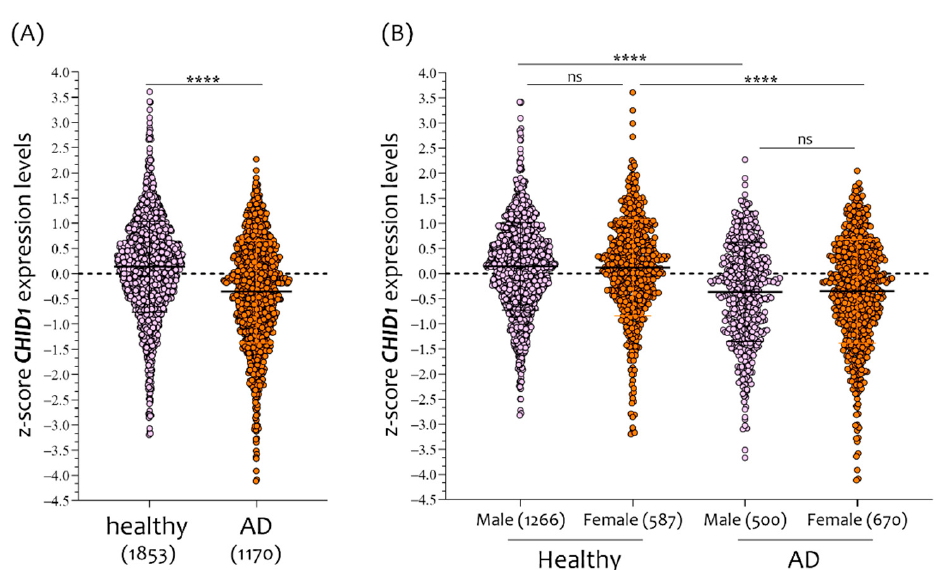
Figure 1. Sex-dependent difference in CHID1 brain expression of NDHC subjects. Analysis of CHID1 expression levels in 1853 NDHC brains subjects and 1170 AD brains patients ( A ), placed in order according to the sex ( B ). Data in the figure are indicated as z-score intensity expression levels and presented graphically as violin dot plots. p values < 0.05 were considered to be statistically significant (ns = not significant; **** p < 0.00001).